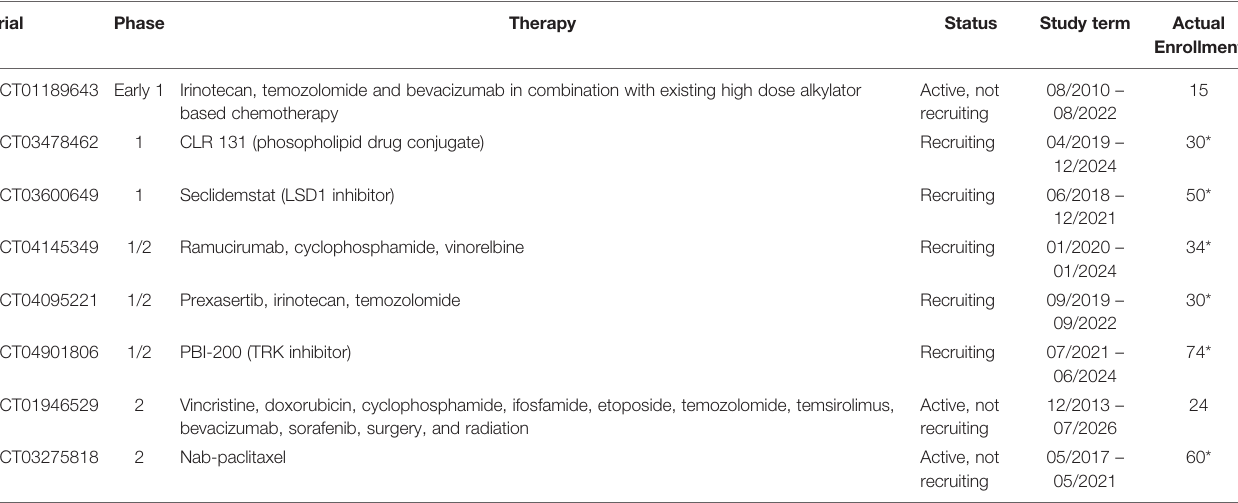
TABLE 1 | Current clinical trials using chemotherapy and targeted therapy for